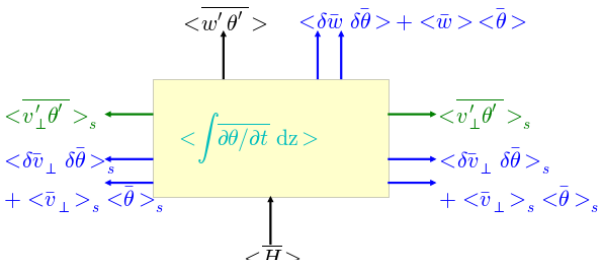
Figure 1. Graphical representation of (5). The control volume is colored in yellow, with horizontal flux-divergence in green, the ad- vection terms in blue, and the storage flux in cyan. The surface flux and the measured turbulent flux are both in black. For clarity the lateral dimension perpendicular to the cross-section is not shown. The direction of the arrows indicate a positive